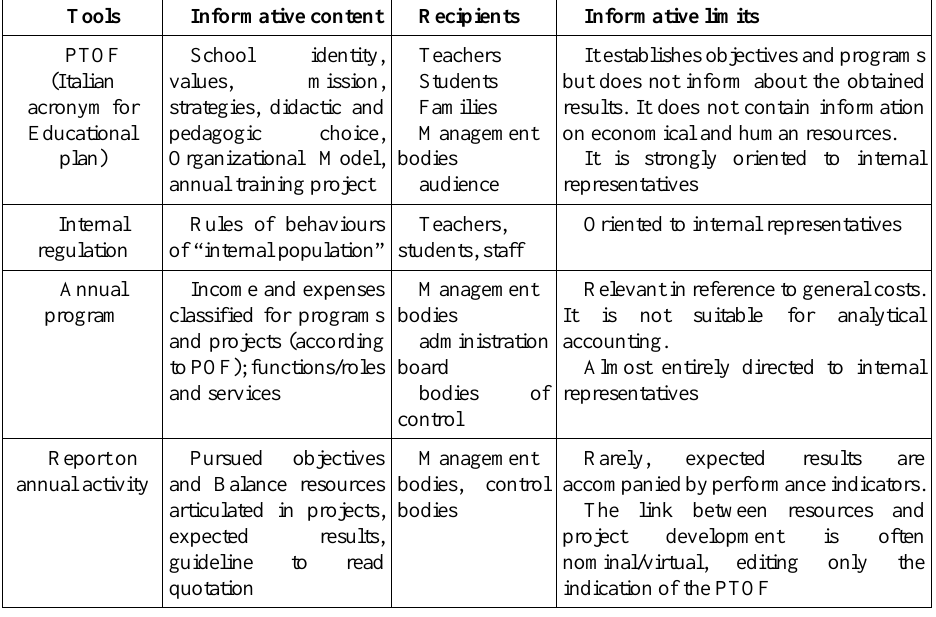
Table 1: Communication Tools in Italian School